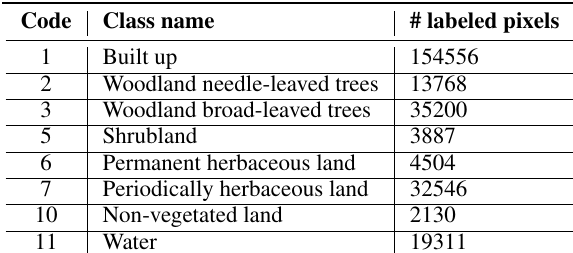
Table 3. Test set repartition using CLC+